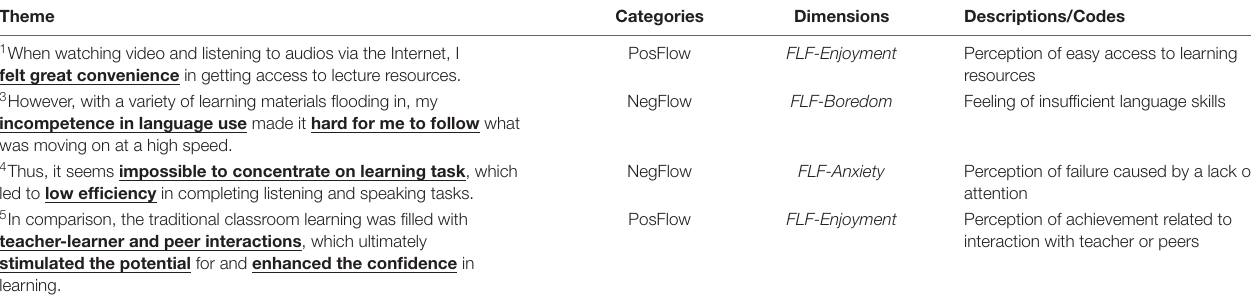
TABLE 4 | Example of the coding